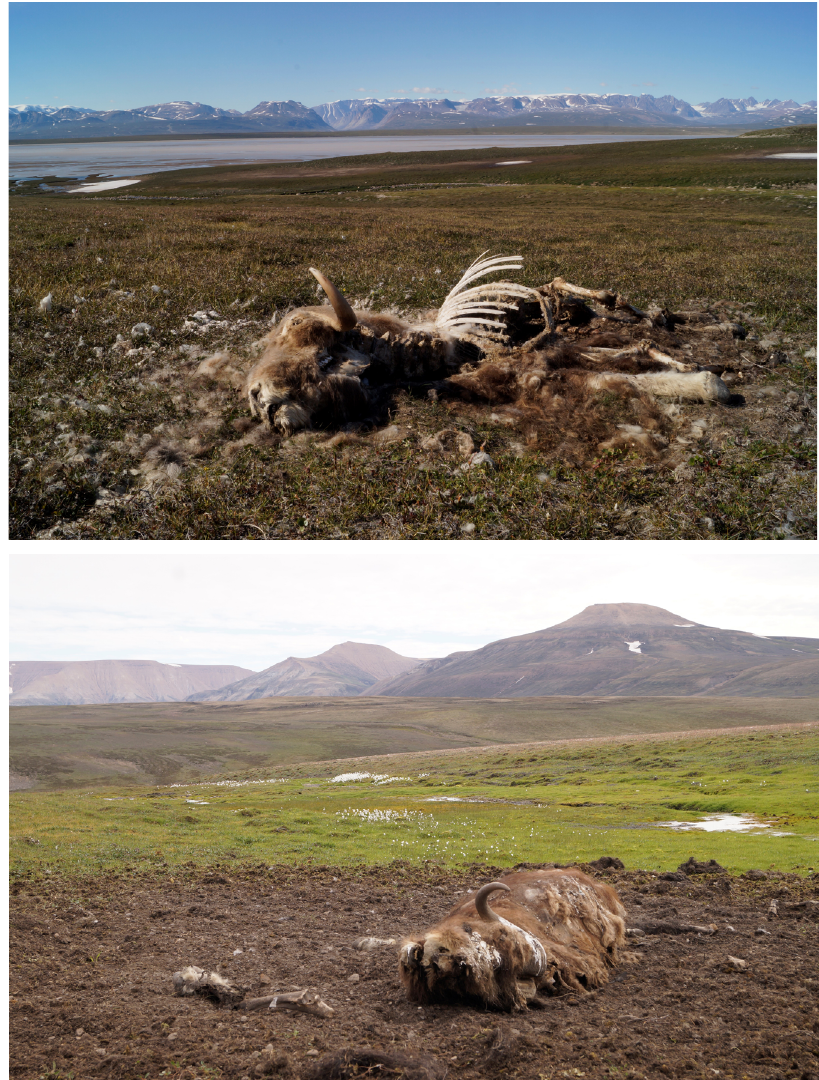
Figure 3. Pictures of carcasses found in July 2016 in the lower Schuchert Dal valley (top) and the Colorado Dal valley (bottom). Photos: T.